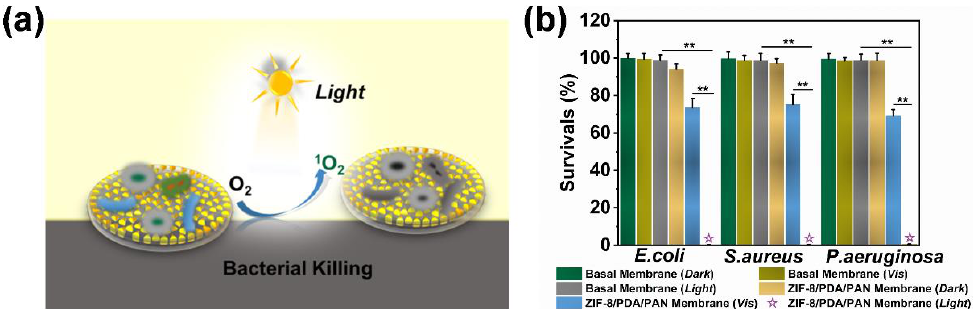
Figure 7. ( a ) Schematic diagram of the photodynamic bactericidal mechanism of the ZIF-8/PDA/PAN composite membrane; ( b ) sterilization efficiency of ZIF-8/PDA/PAN composite membrane on E. coli , S. aureus , and P. aeruginosa ( n = 3, ** p < 0.01).